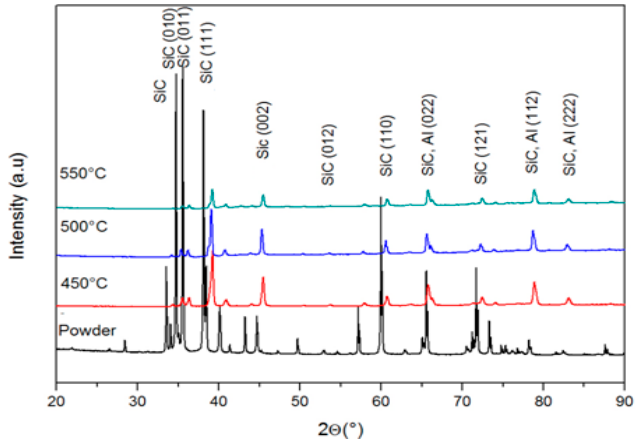
Figure 5. XRD of the coatings in comparison with the feedstock powder.